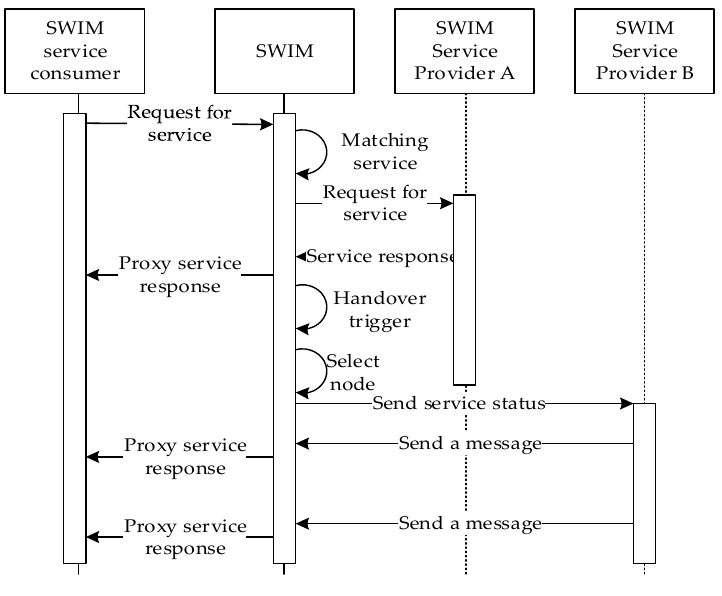
Figure 9. SSM method interaction process.